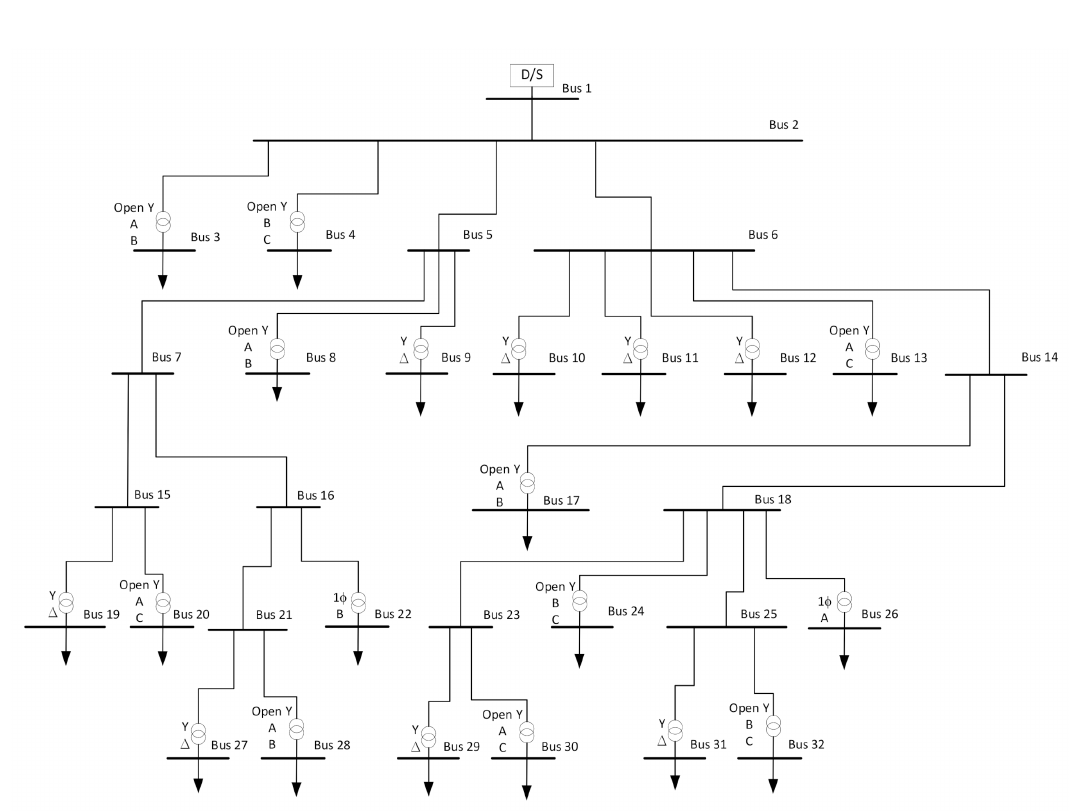
Figure 7. The practical feeder